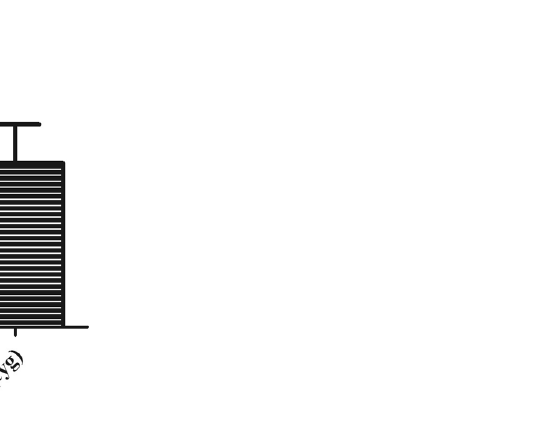
Figure 5. Sensitivity of Enterococcus isolates to different antibiotics as analyzed by MIC. Tyg: tigecycline; Van: vancomycin; Cip: ciprofloxacin; Gen: gentamycin; Azi: azithromycin.